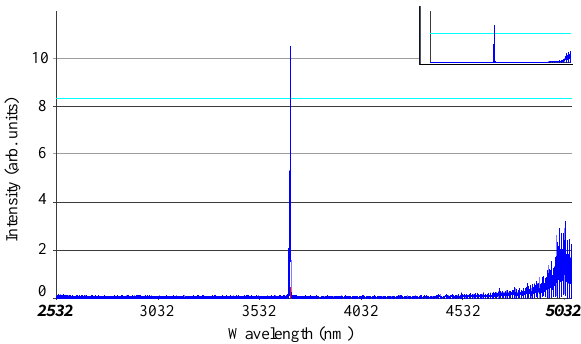
Figure 2. Idler wavelength of the MgO:PPLN OPO at temperature T = 120 °C for the grating period Λ = 29.5 µ m.